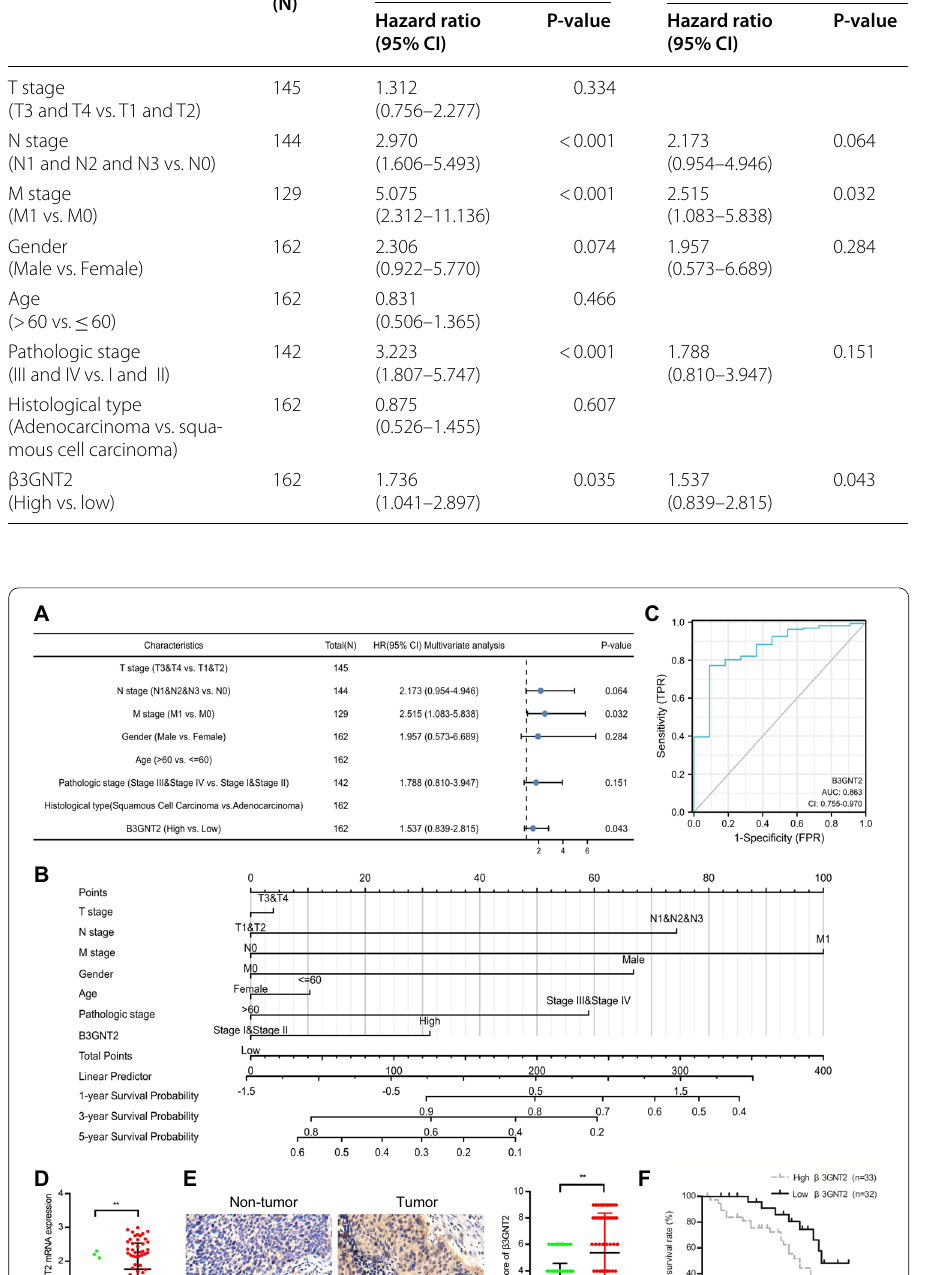
Table 1 Univariate and multivariate analysis of overall survival (Cox regression model) Characteristics